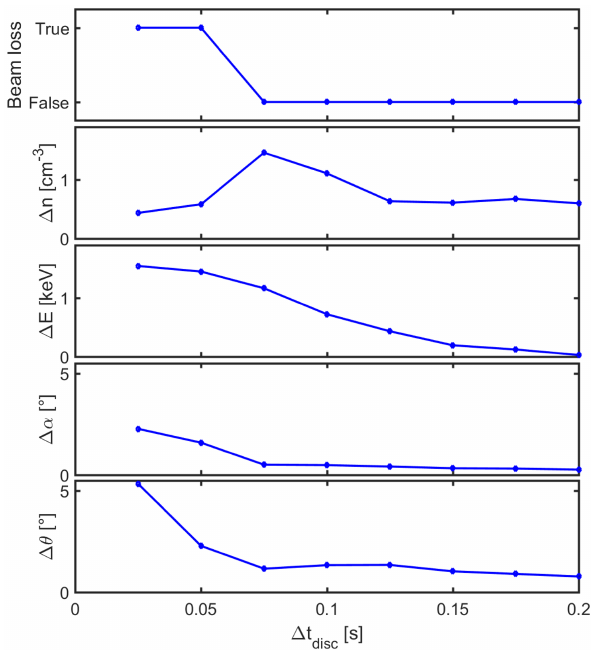
Figure 6. Plasma spectrometer measurements during the passage of a plasma discontinuity. The spectrometer uses internal energy and elevation beam tracking. The plot shows the occurrence of beam loss (true or false) and the maximum deviations in plasma density, energy, azimuth, and elevation between the measured values and the true solar wind values that occur throughout the passage, as a func- tion of the discontinuity crossing duration t disc . The measurements are more accurate as the plasma property changes associated with the discontinuity occur over a longer